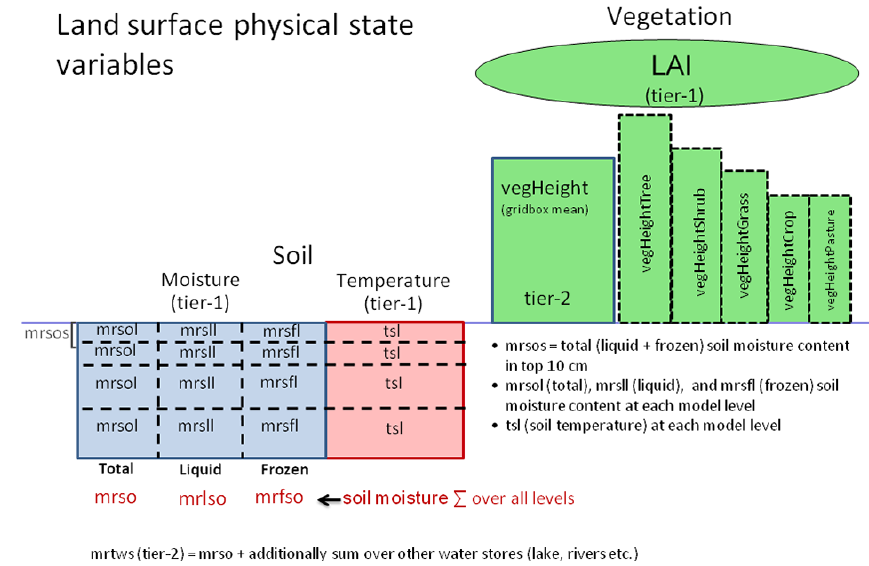
Figure 9. Requested state variables that characterize the physical vegetation structure and the physical state of the soil.